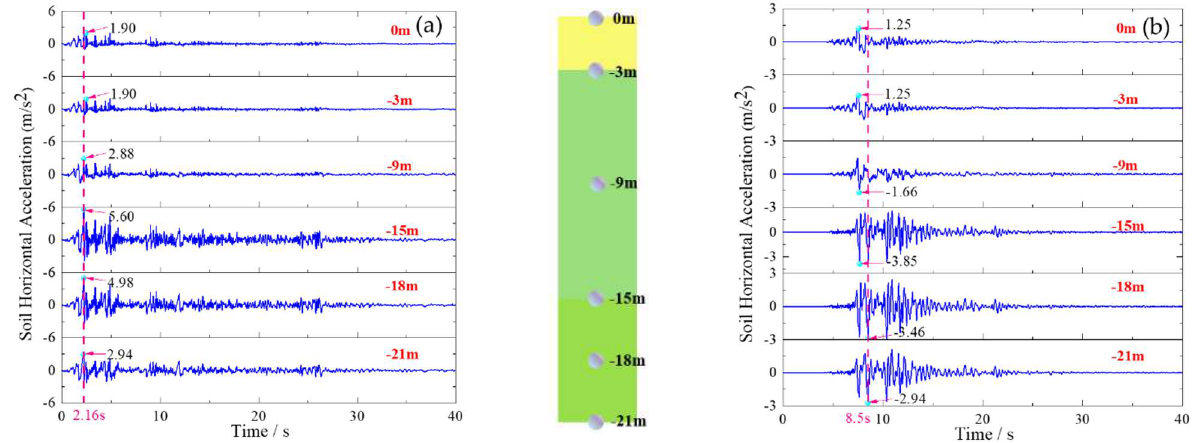
Figure 10. Free-field acceleration time histories at different depths ( a ) under the El-Centro motion; ( b ) under the Kobe Motion.